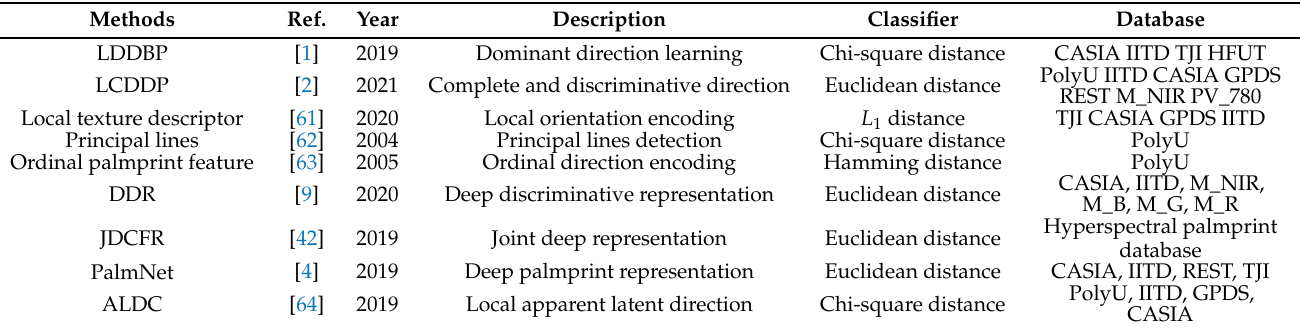
Table 3. Overview of single-view palmprint representation